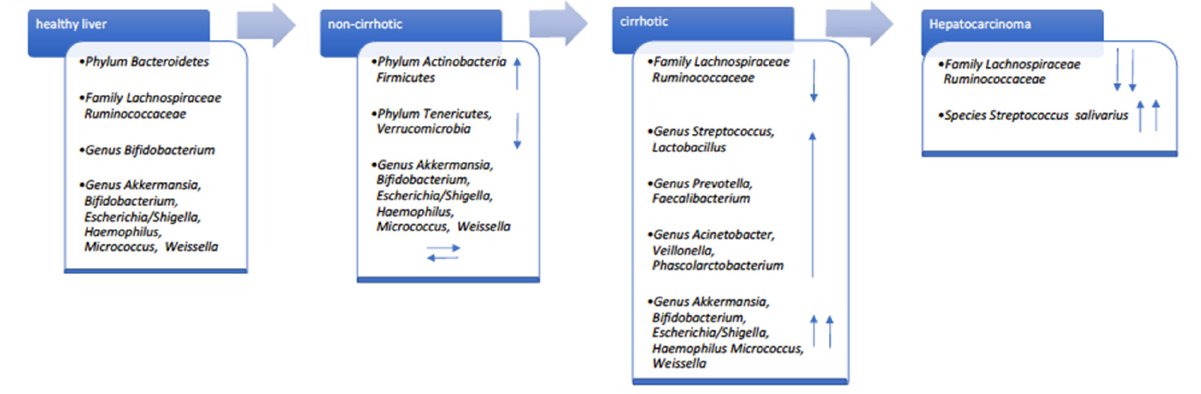
Figure 2. Gut taxonomy increased and decreased prevalence (blue arrows) according to liver disease stage of patients versus healthy controls.